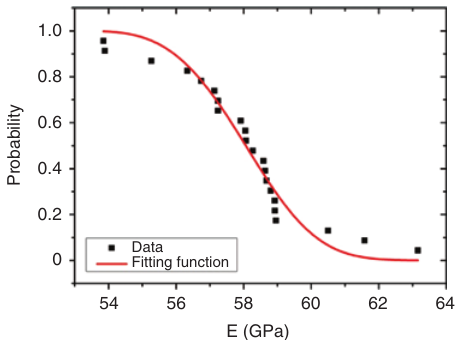
Figure 11: Rank-ordered distribution of effective elastic moduli in the DDD simulations. Data points: simulation data; red line corresponds to fit assuming a Weibull distribution.